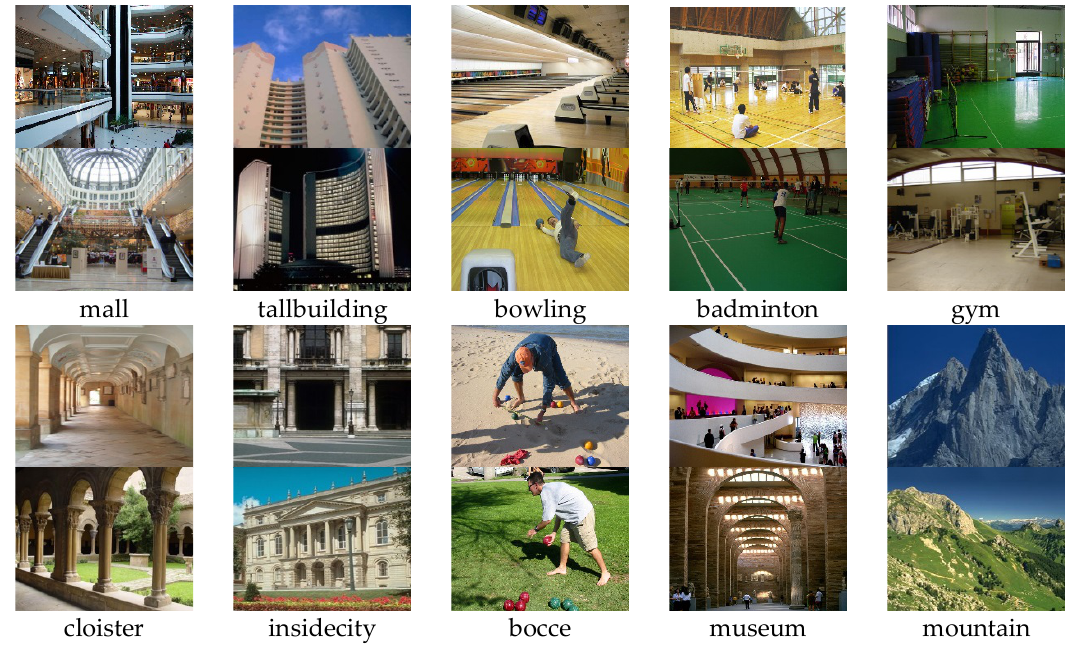
Figure 6. A few examples in the combined dataset.